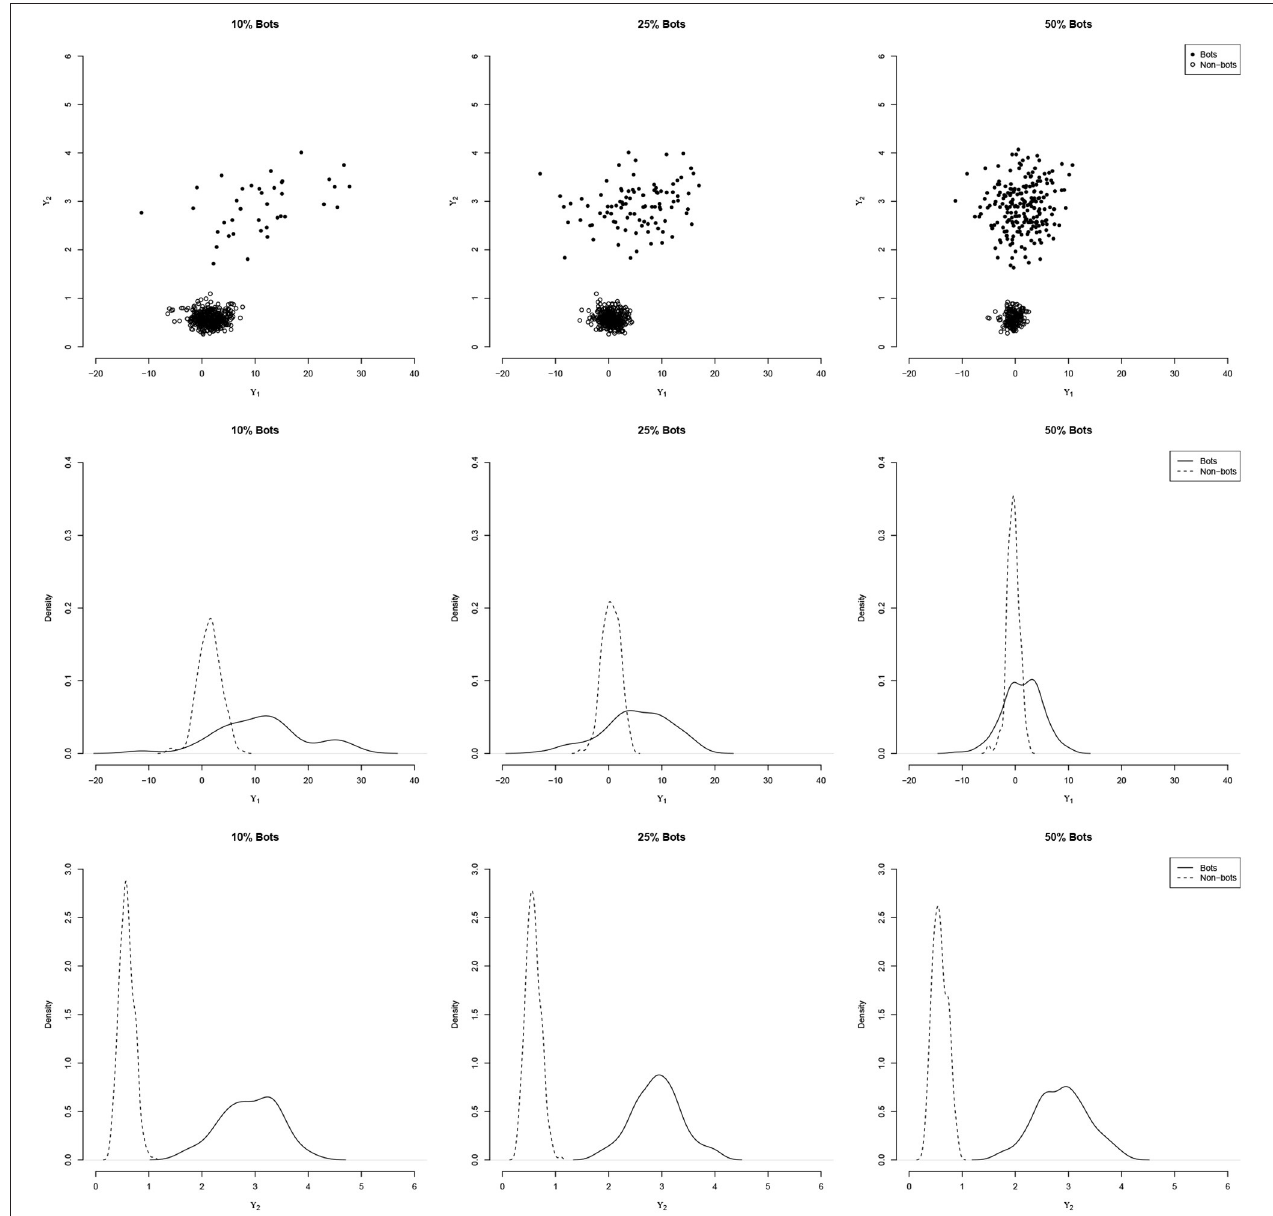
FIGURE 1 | Illustration of the performance of the person-fit index ϒ 1 and the variability coefficient ϒ 2 to distinguish bots from Non-bots under different levels of contamination. The (top) panels show the bivariate distribution, the (middle and bottom) panels show the densities for person-fit index ϒ 1 and variability coefficient ϒ 2 , respectively. While the distinction between bots and non-bots becomes more difficult with the person-fit index with increasing contamination, the variability coefficient remains